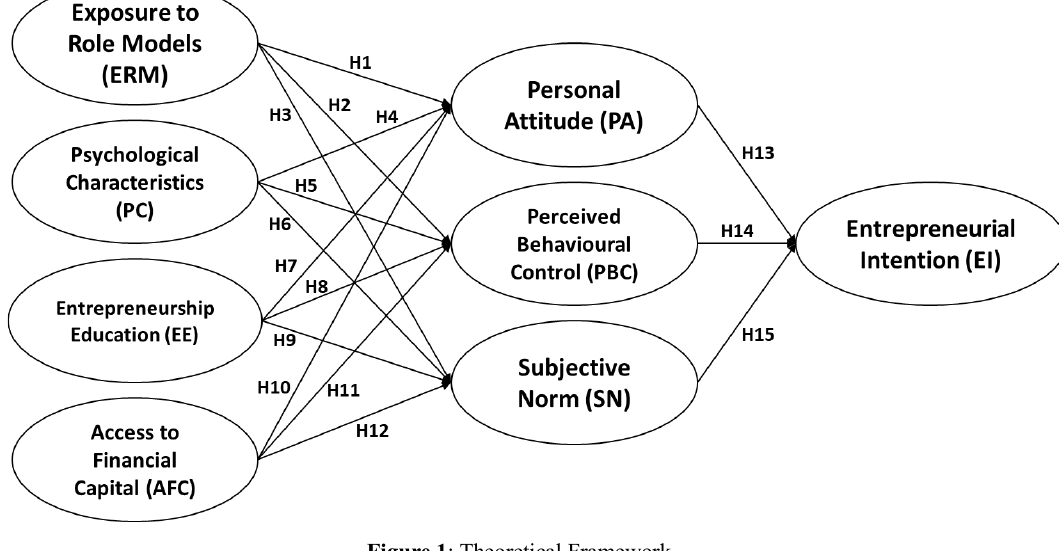
Figure 1 : Theoretical